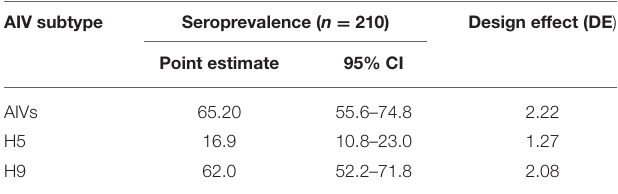
TABLE 2 | Overall seroprevalence of H5 and H9 estimated from 210 backyard birds in villages of Lahore district (in